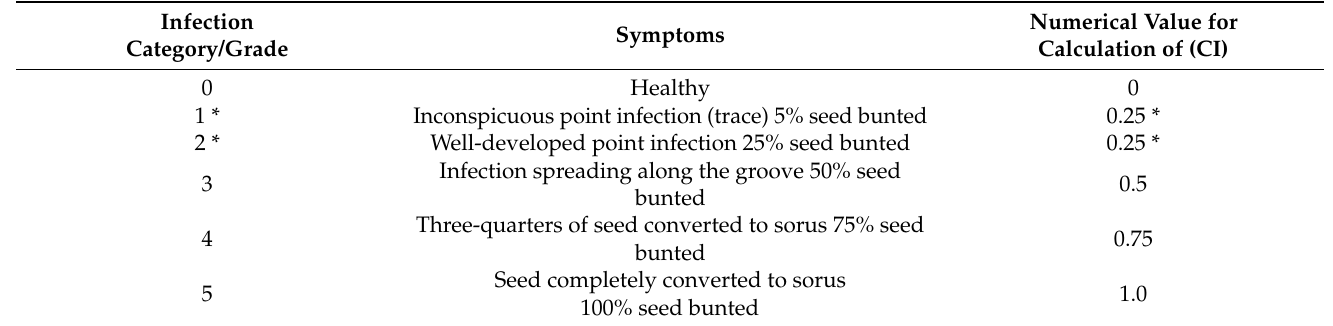
Table 2. Rating scale used to assess wheat cultivars for Karnal bunt ( Tilletia indica